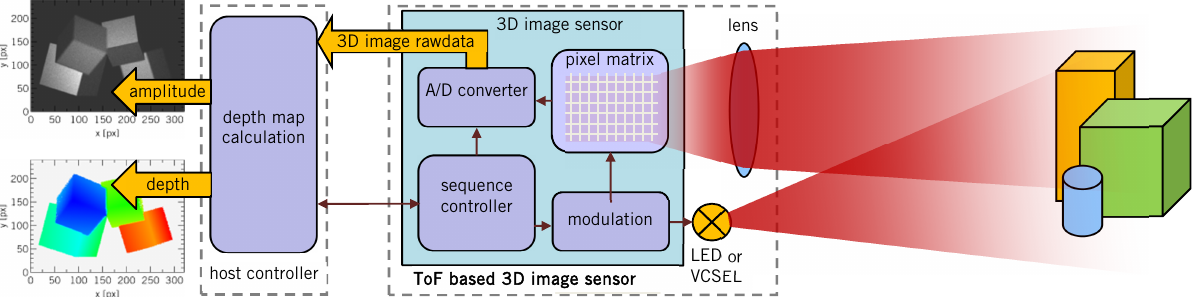
Figure 1. Measurement principle of a camera-based ToF sensor using the amplitude modulated continuous wave measurement technique (REAL3 TM 3D Image Sensor, adapted from (Druml et al.,